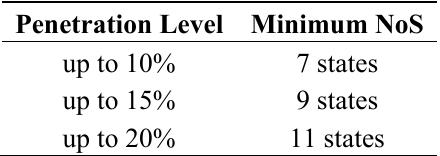
Table 2. NoS for wind capacity